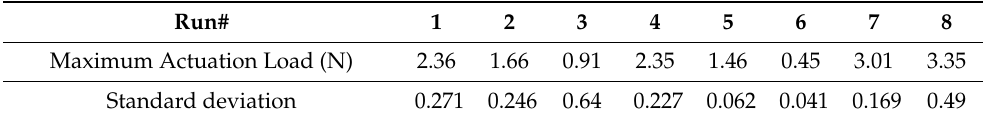
Table 3. Average measured actuation load values for each experiment.